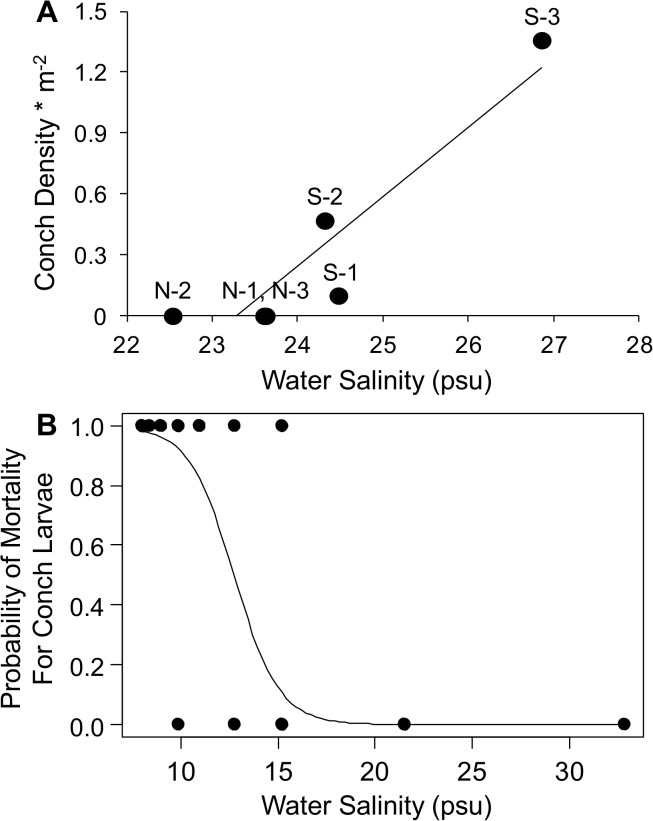
Relationships between crown conchs and water salinity based on observational and experimental evidence.(A) The relationship between crown conch abundance and water salinity of the six study sites in the Matanzas River estuary. (B) In experiment 3, results of logistic regression that examined the probability of larval mortality as a function of salinity after 14 days of exposure.